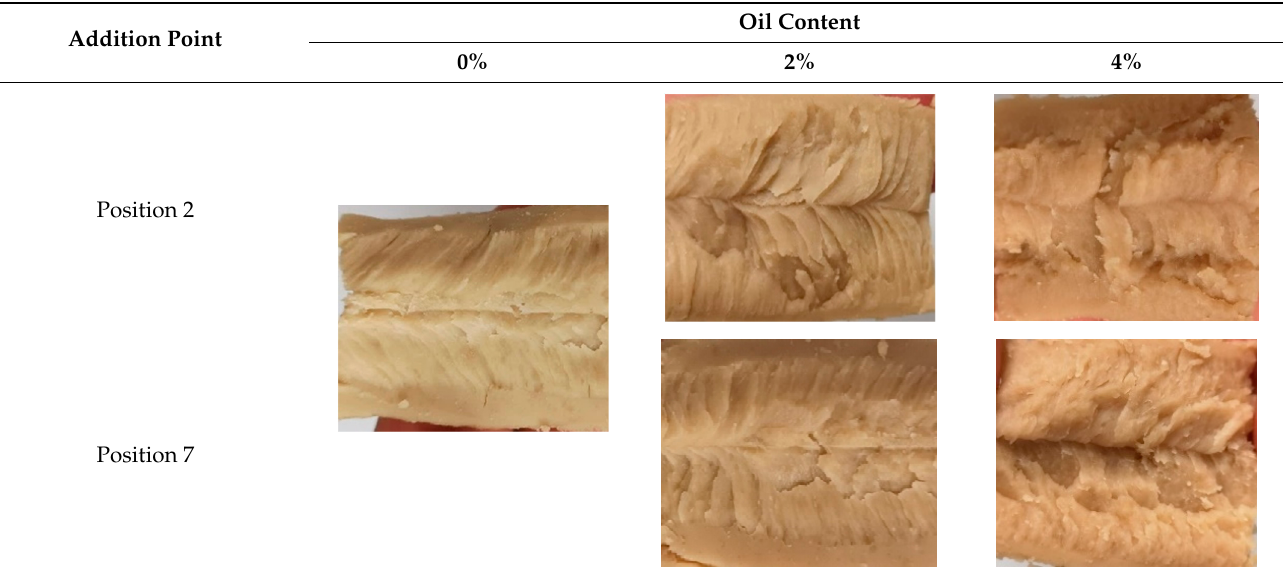
Table 1. Images of the extrudate samples teared immediately after extrusion processing. Influence of oil content on the anisotropic structure as a function of the oil addition point (position 2 and 7). The barrel temperature was 120 °C, screw speed was 400 rpm, total mass flow was 10 kg/h and water content was 51–53% for all samples.